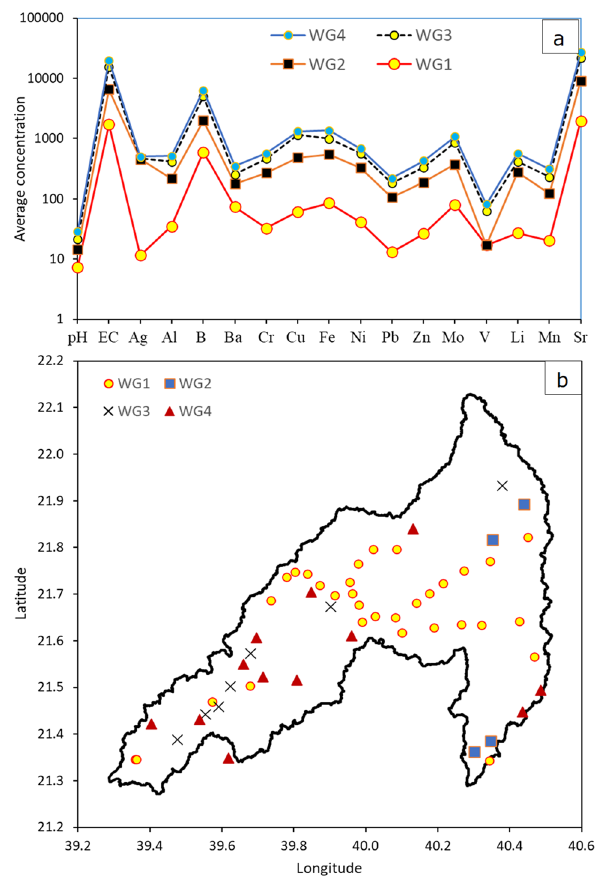
Fig. 7 The average values of pH, EC (µS/cm) and trace metals (µg/l) in HCA groups ( a ) and their spatial distribution ( b ) in the study